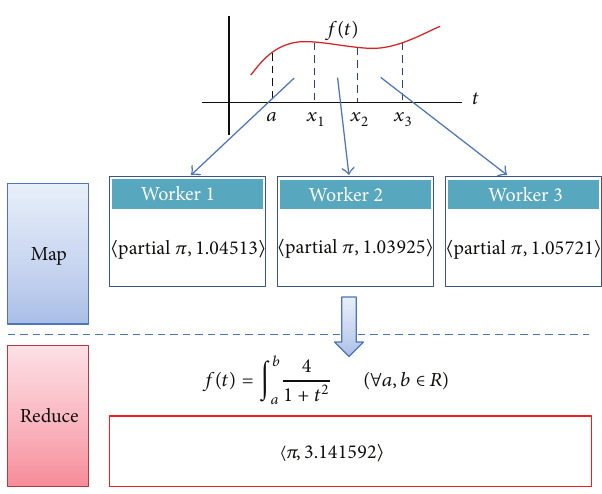
Figure 2: MapReduce computation process on our